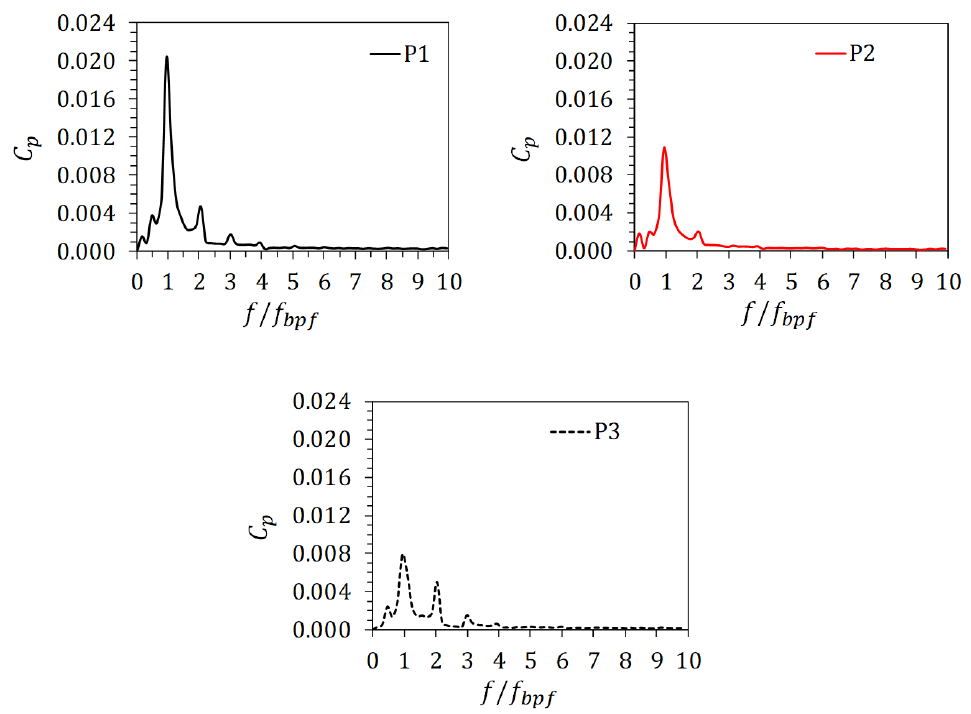
Figure 18. Frequency spectra of the pressure fluctuation on monitoring points P 1, P 2, and P 3.